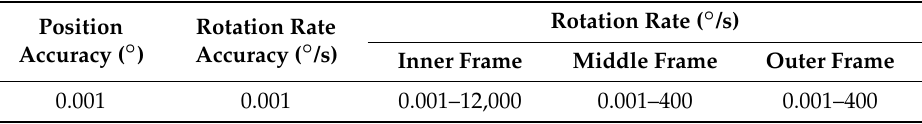
Table 8. Characteristics of IMU in the optimized Semi-Strapdown Inertial Navigation System ( SSINS).